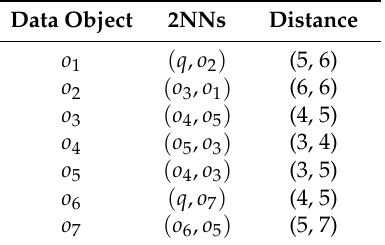
Table 2. Summary of 2NNs for o ∈ O